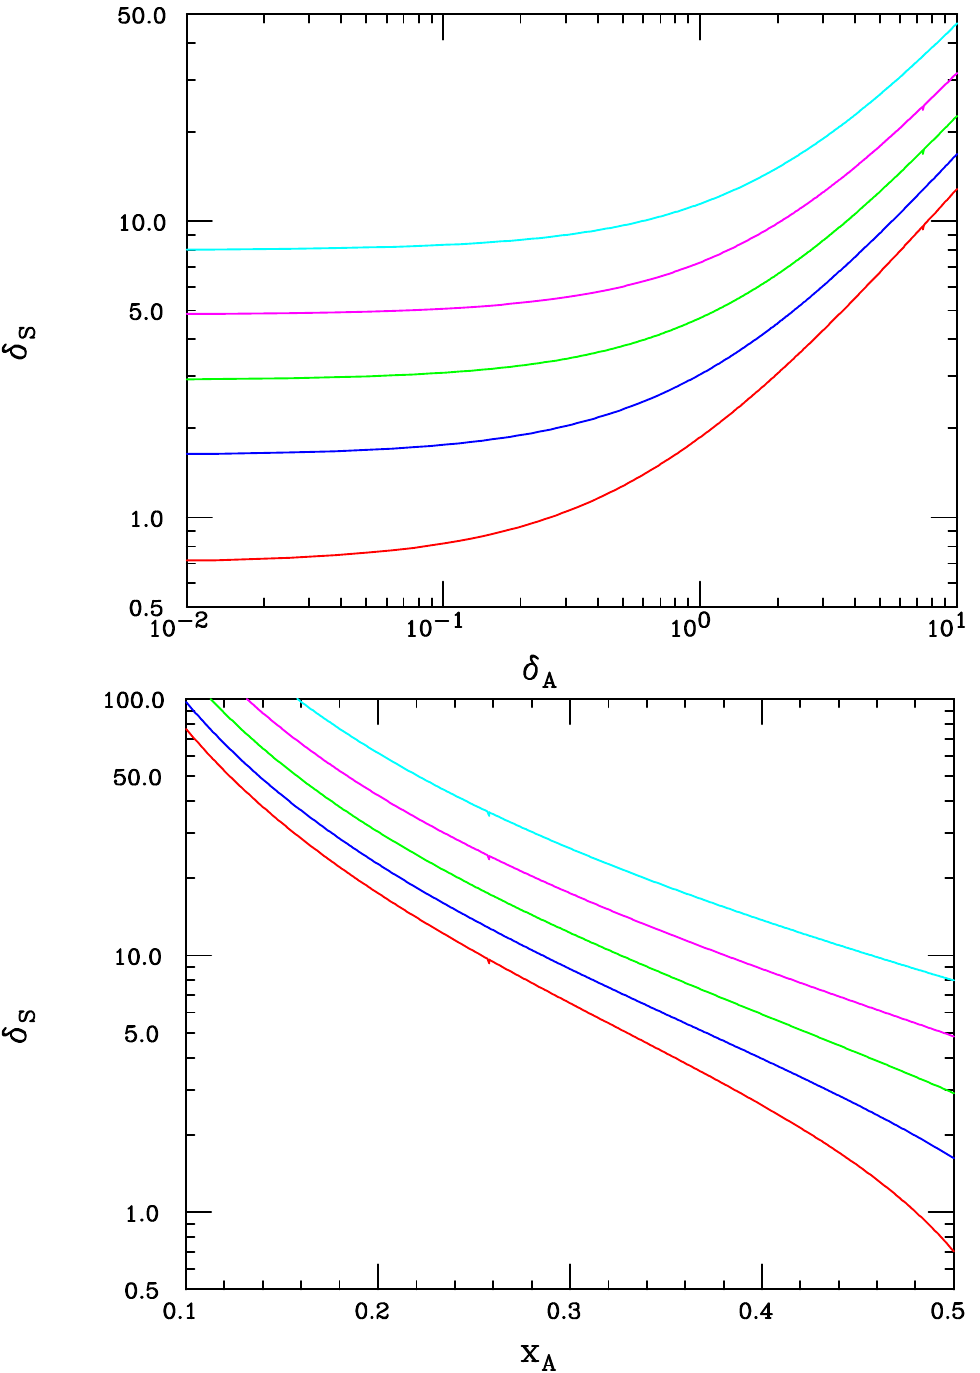
Figure 5 . Top: values of (cid:14) S as functions of (cid:14) A for (from top to bottom) (cid:21) = 0 : 5 ; 0 : 6 ; : : : ; 0 : 9. Clearly the x V;S values are identical when (cid:14) A = (cid:14) S . Bottom: same as the Top panel but now as a n function of the input value of x A = x V . 1